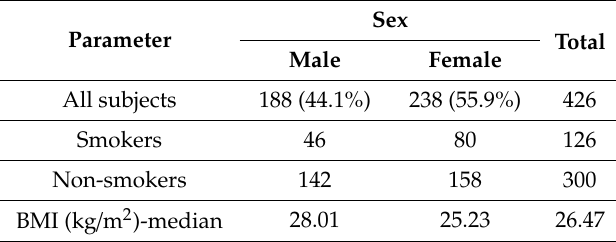
Table 1. Characteristics of